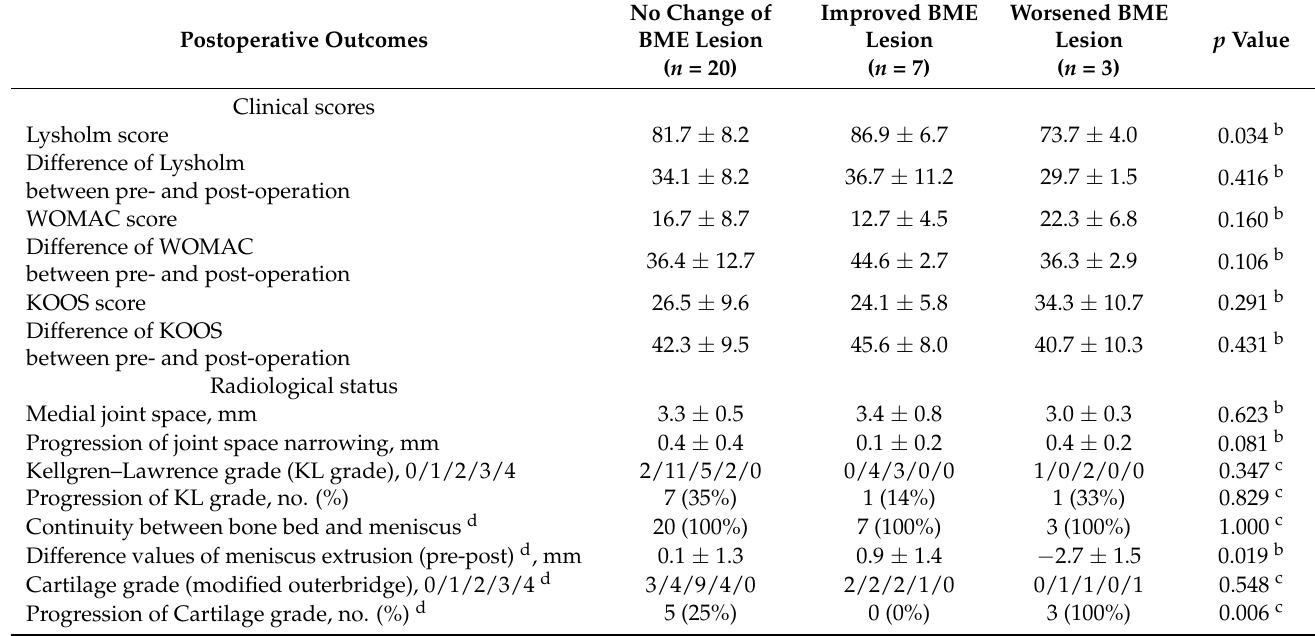
Table 4. Postoperative Clinical and Radiological Outcomes Between Groups a